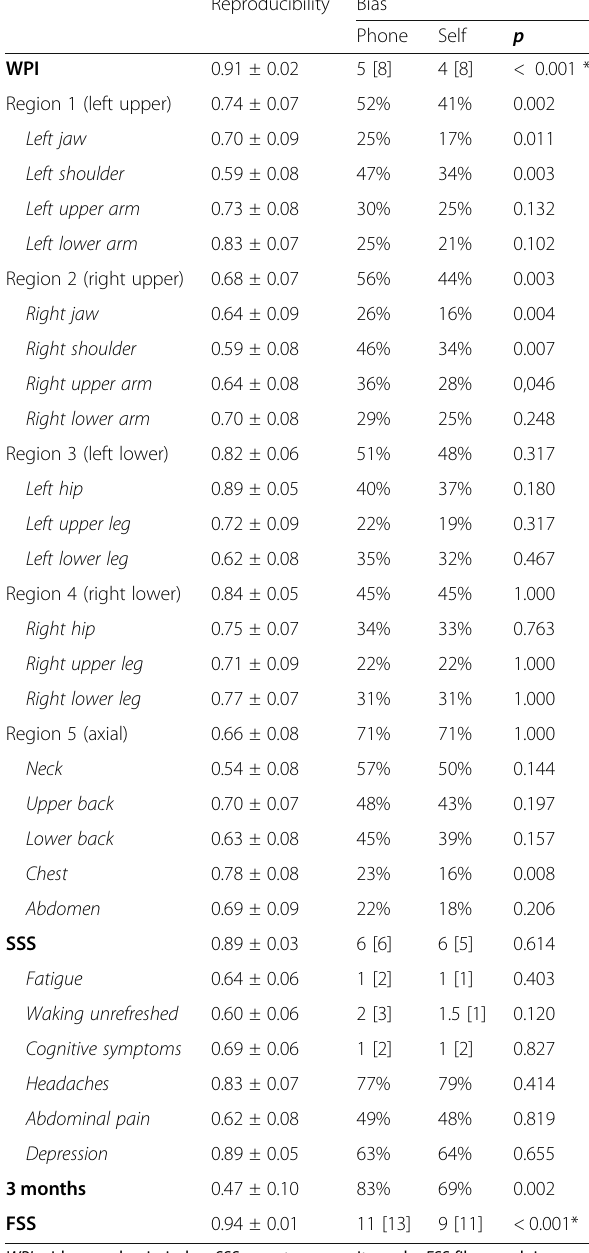
Table 2 Reproducibility of Fibromyalgia Survey Questionnaire (Brazil) by telephone